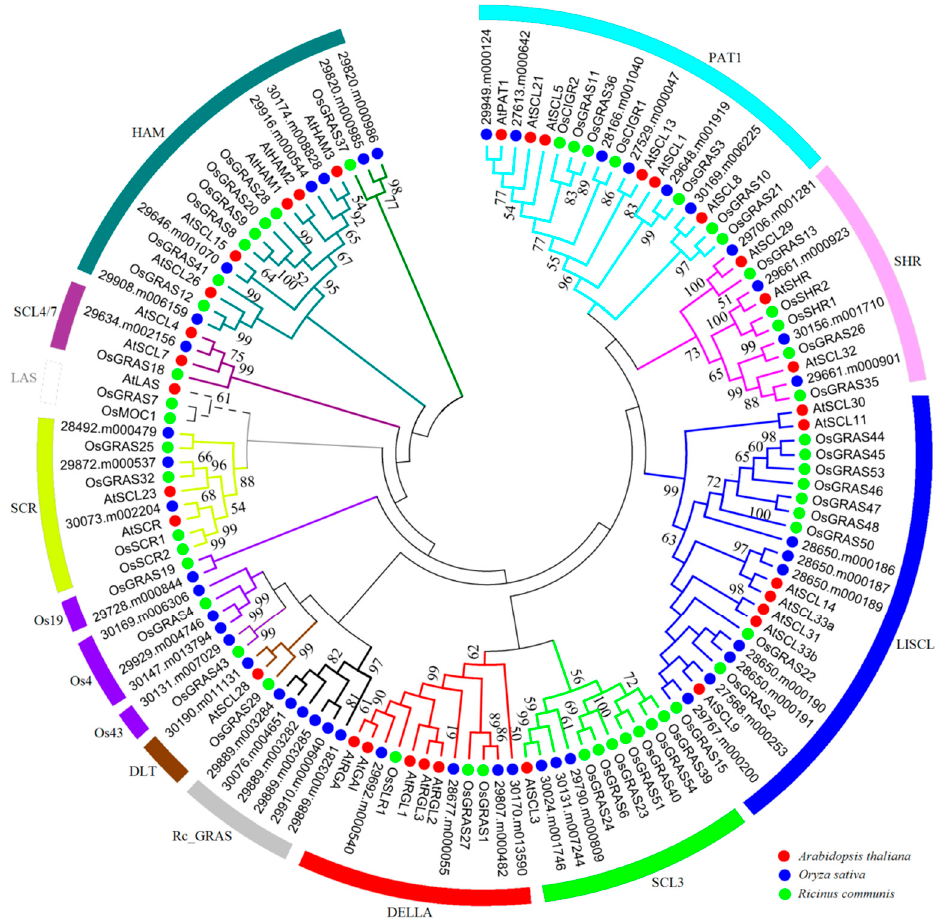
Figure 1. An unrooted phylogenetic tree of GRAS transcription factors from Arabidopsis thaliana , rice and castor beans. The multiple sequence alignment of GRAS proteins including Arabidopsis thaliana (red dots), castor beans (green dots) and rice (blue dots) were carried out using Clustal W [44], and the tree was generated with neighbor-joining methods. Members in the same clade were marked by the same color.